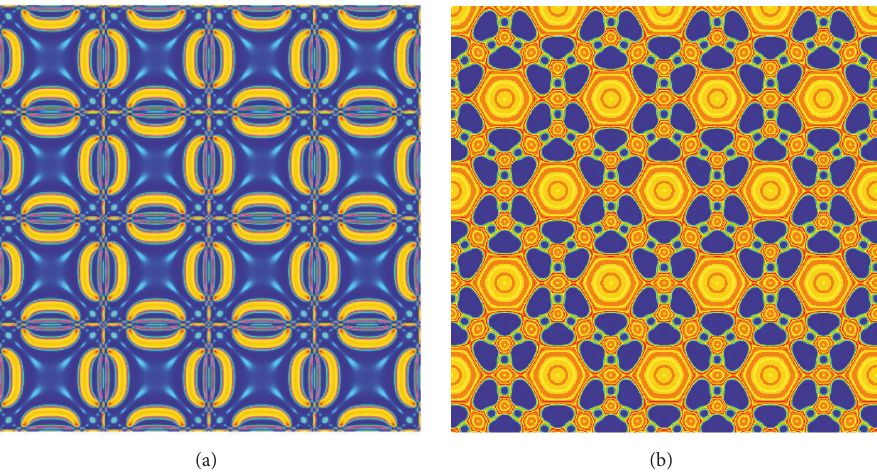
Figure 1: Colorful wallpaper patterns with the 𝑝4𝑚 (a) and 𝑝6𝑚 (b) symmetry.